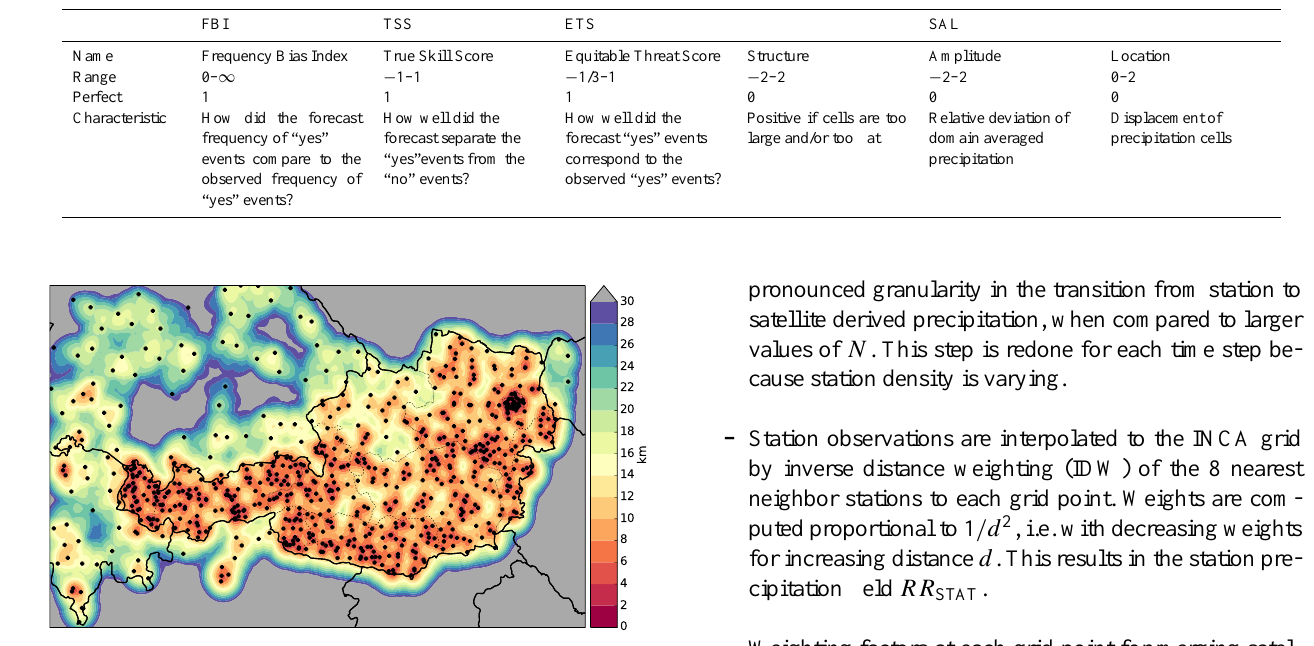
Figure 1. This figure depicts the SATIN domain (same as INCA op- erational domain). Black dots represent automatic weather stations entering the SATIN algorithm. Average distance for three nearest neighbors is shown (with a cutoff at distances larger than